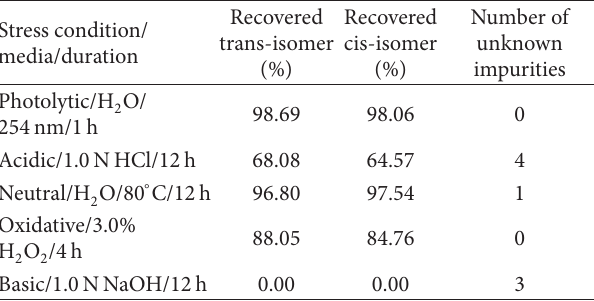
T 1: Summary of stress degradation studies of